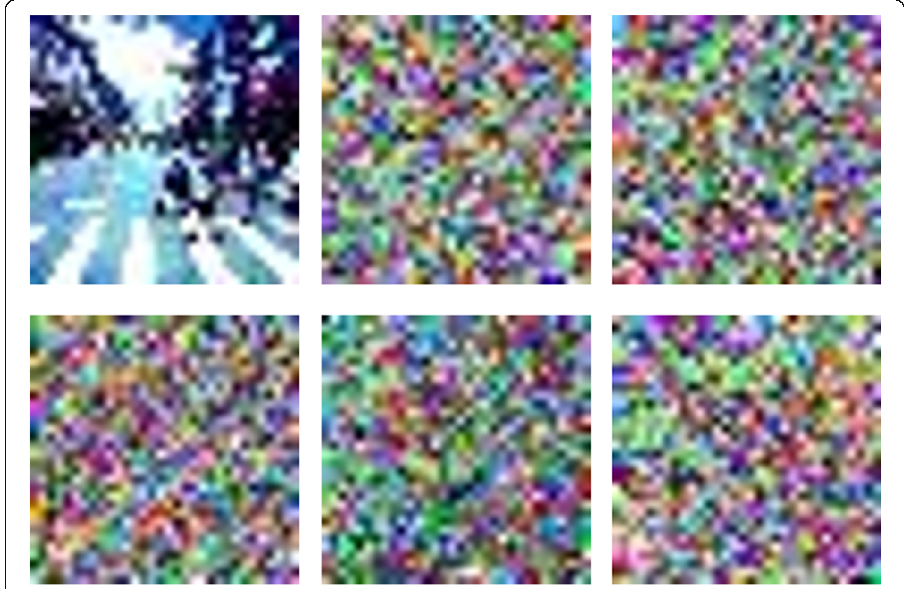
Fig. 1 An initial image and 5 trigger images in a hash